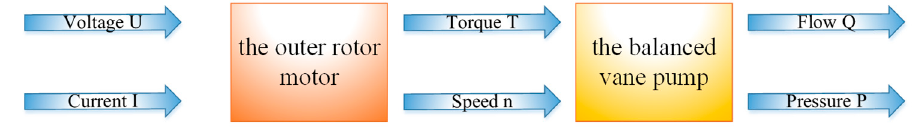
Figure 6. The energy conversion flowchart of the proposed IEHVP.